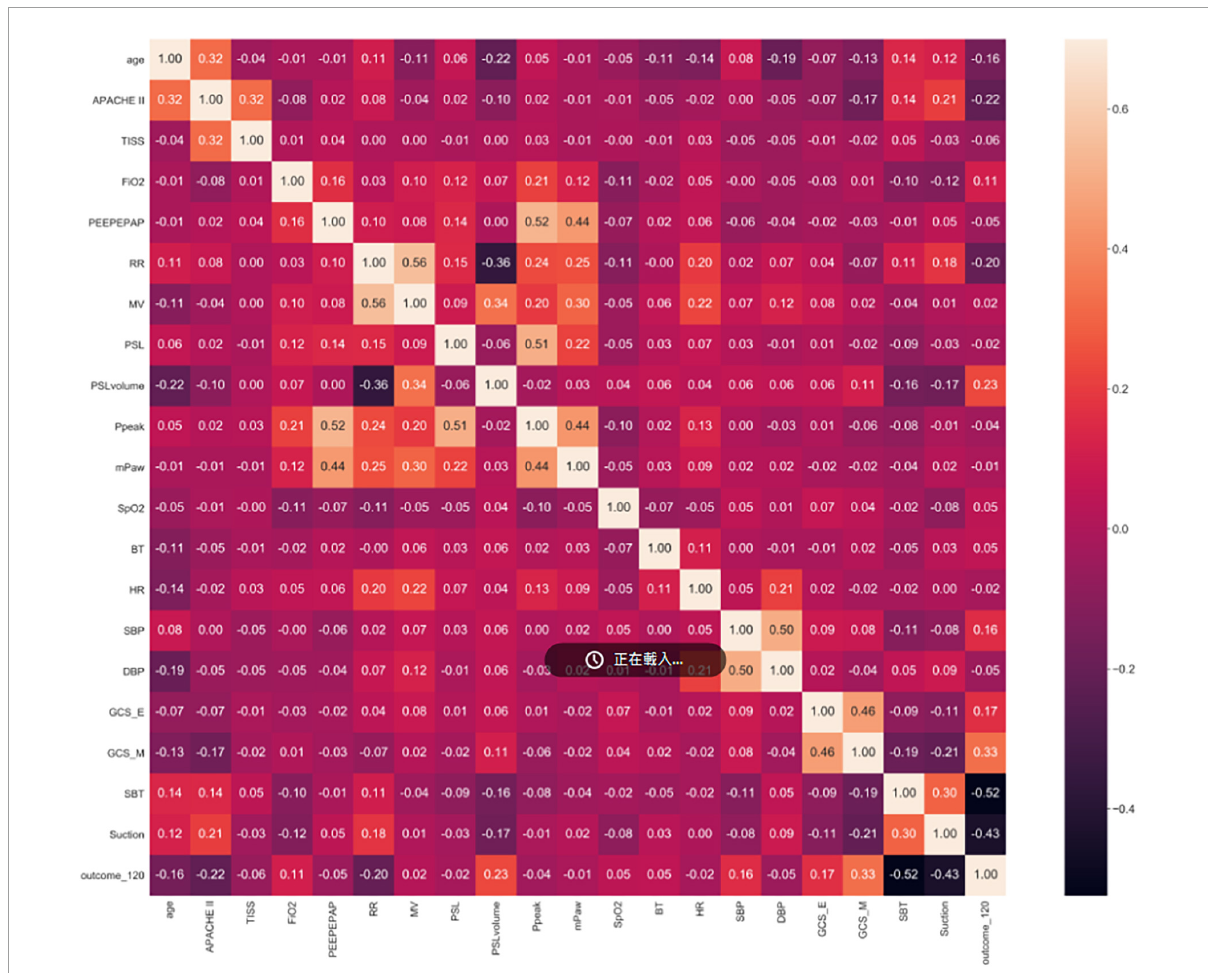
FIGURE5 Stage 2 Spearman correlation (the 120th Hour model). Note: outcome_120: Successful weaning or not before using 120 h of MV, others are labeled